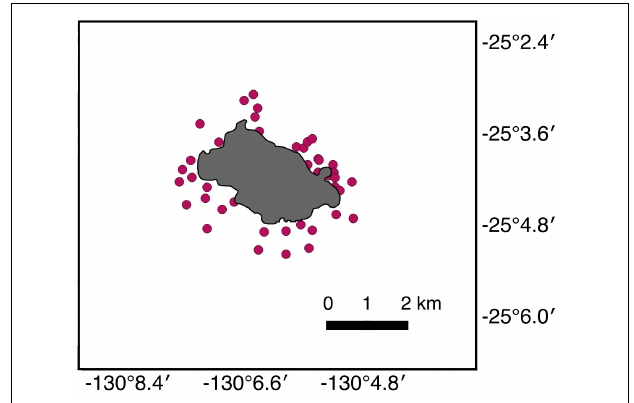
FIGURE 3 | Map of the Pitcairn Island field site, with each dot denoting the site of a single BRUVS deployment.